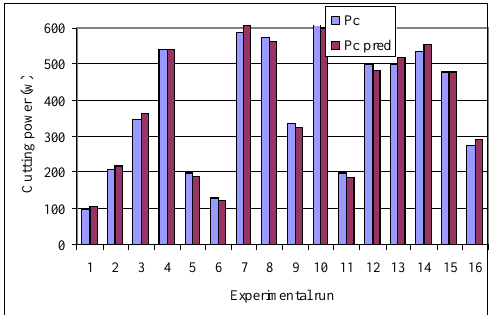
Fig. 3. Experimental and predicted RSM values of surface roughness